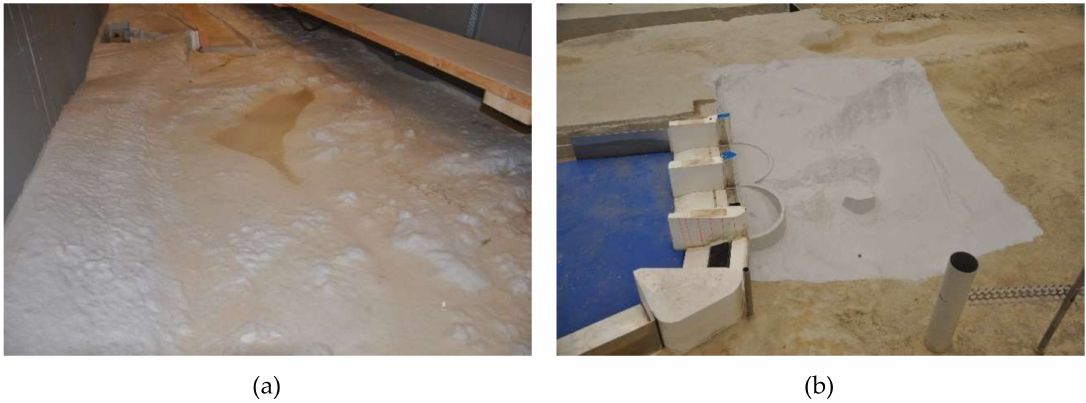
Figure 4. Models produced with the milling technique: ( a ) Stornorrfors, λ = 50; ( b ) Lilla Edet, λ =